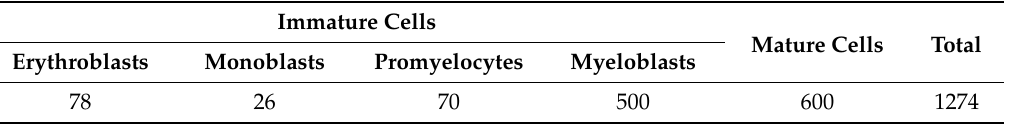
Table 1. Data coverage for four immature leukocyte types, total immature leukocytes, and total mature leukocytes.